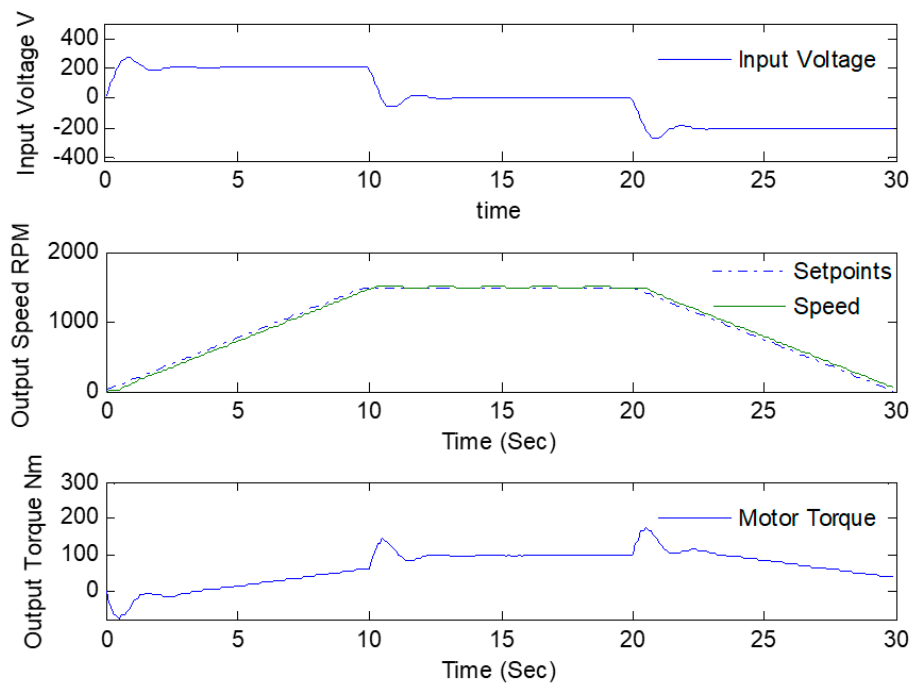
Figure 7. The MPC for the HEV with 𝑁 (cid:3043) = 5 , Q = 100, and R = 1.